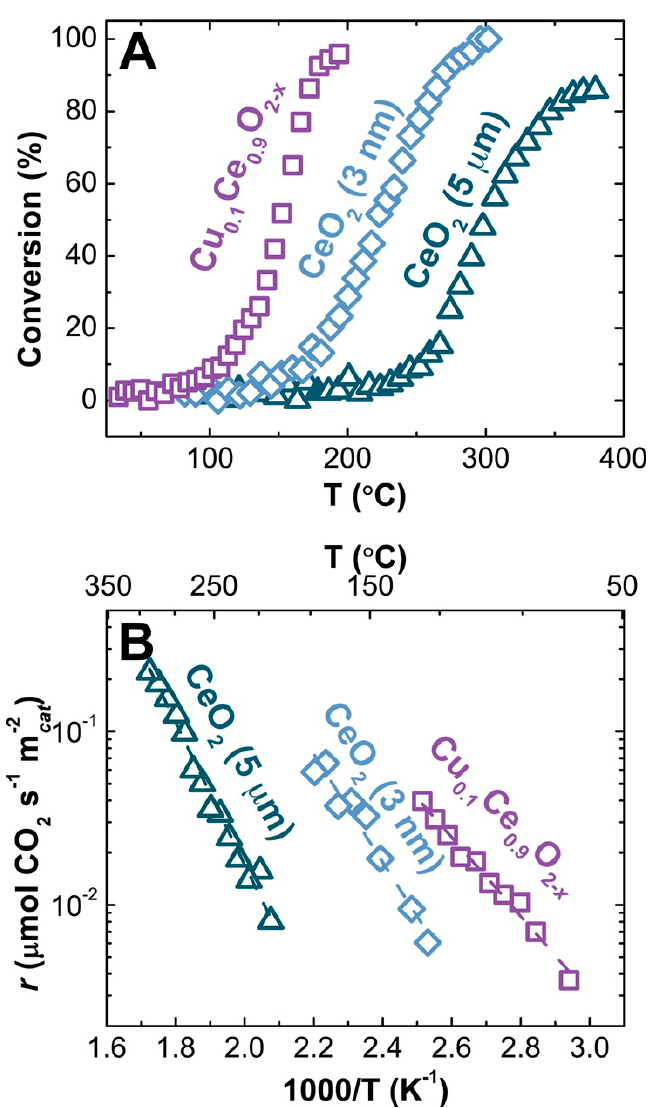
Figure 13. CO oxidation on annealed 3 nm Cu 0.1 Ce 0.9 O 2 − x , 3 nm CeO 2 and commercial 5 μ m CeO 2 (Sigma-Aldrich). ( A ) “Light off” curves and ( B ) area-normalized Arrhenius plots, measured in 1.0% CO, 2.5% O 2 balanced in He at a flow rate of 1300 mL min − 1 g cat − 1 for 20 mg catalyst loadings. Reproduced with permission from Reference [236]. Copyright © 2014, American Chemical Society.